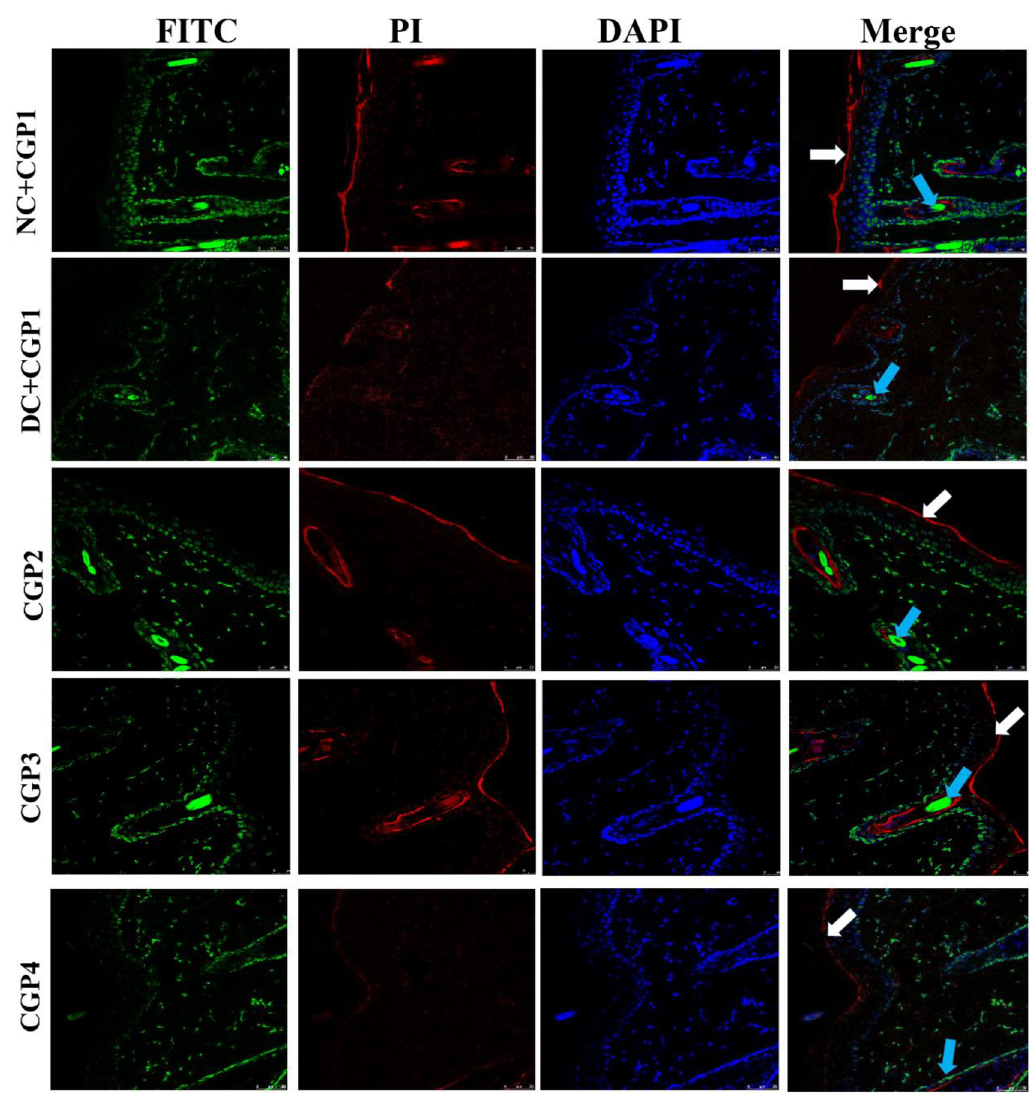
Fig 4. Effect of GC-AgNP CGPs dressing on Wnt3a and β -catenin in diabetic rats. Immunofluorescence double staining images showing co-localization of Wnt3a (red) and β -catenin (green). White arrows point towards the distribution of Wnt3a protein and blue arrow point towards the distribution of β -catenin. NC+CGP1: Normal control dressed with blank cotton gauze; DC+CGP1: Diabetic control rats dressed with blank cotton gauze; CGP2: Diabetic rats dressed with 13.06 μ M gallocatechin and silver nanoparticle (GC-AgNP) impregnated cotton gauze patches (DC+ 13.06 μ M CGP2); CGP3: Diabetic rats dressed with 26.12 μ M gallocatechin and silver nanoparticle (GC-AgNP) impregnated cotton gauze patches (DC+ 26.12 μ M CGP3). CGP4: Diabetic rats dressed with silver sulfadiazine (DC+AgS) impregnated cotton gauze patches. Data were expressed as mean ± S.E.M (n = 6). Scale bar = 100 μ m.